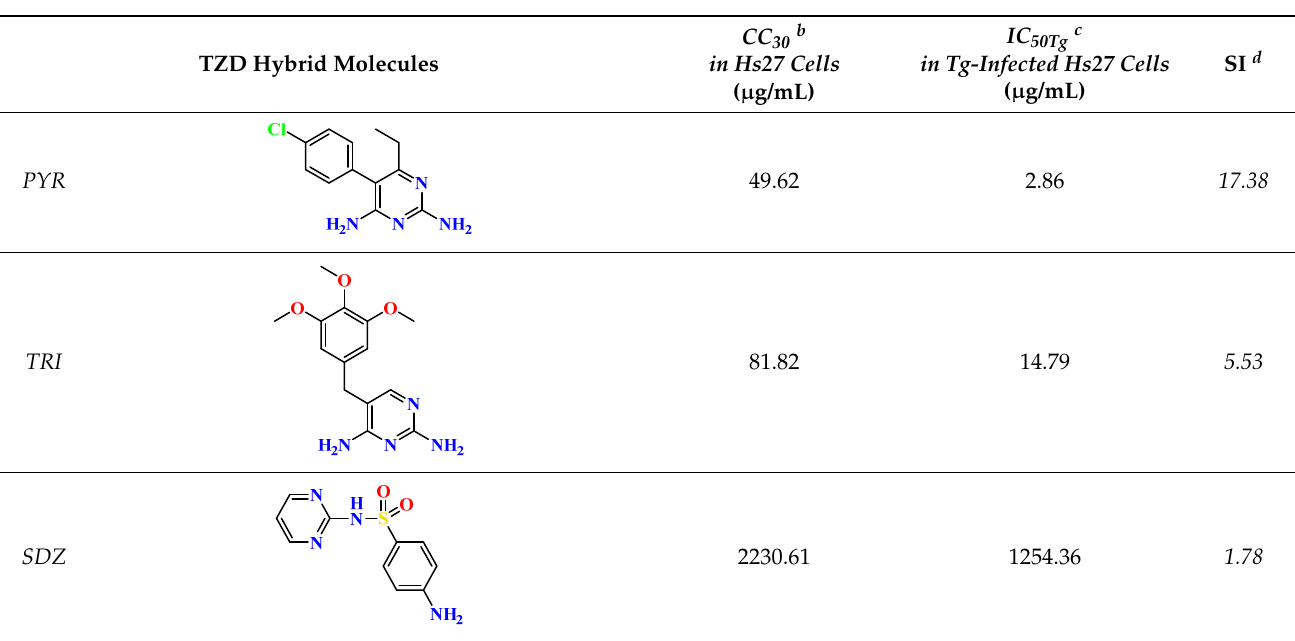
Figure 2. Synthetic route for TZD-PCH ( 1 – 6 ) and TZD-TSC ( 7 – 12 ) hybrid molecules. Reagent and conditions : ( i ) corresponding hydroxybenzaldehyde, pyridine, 1,4-dioxane, rt, 2h, acidified with dilute HCl; ( ii ) isonicotinic acid hydrazide, anhydrous ethanol, reflux; ( iii ) TSC, anhydrous ethanol, reflux. For the numbers used to identify the TZD hybrid molecules ( 1 – 12 ), see Table